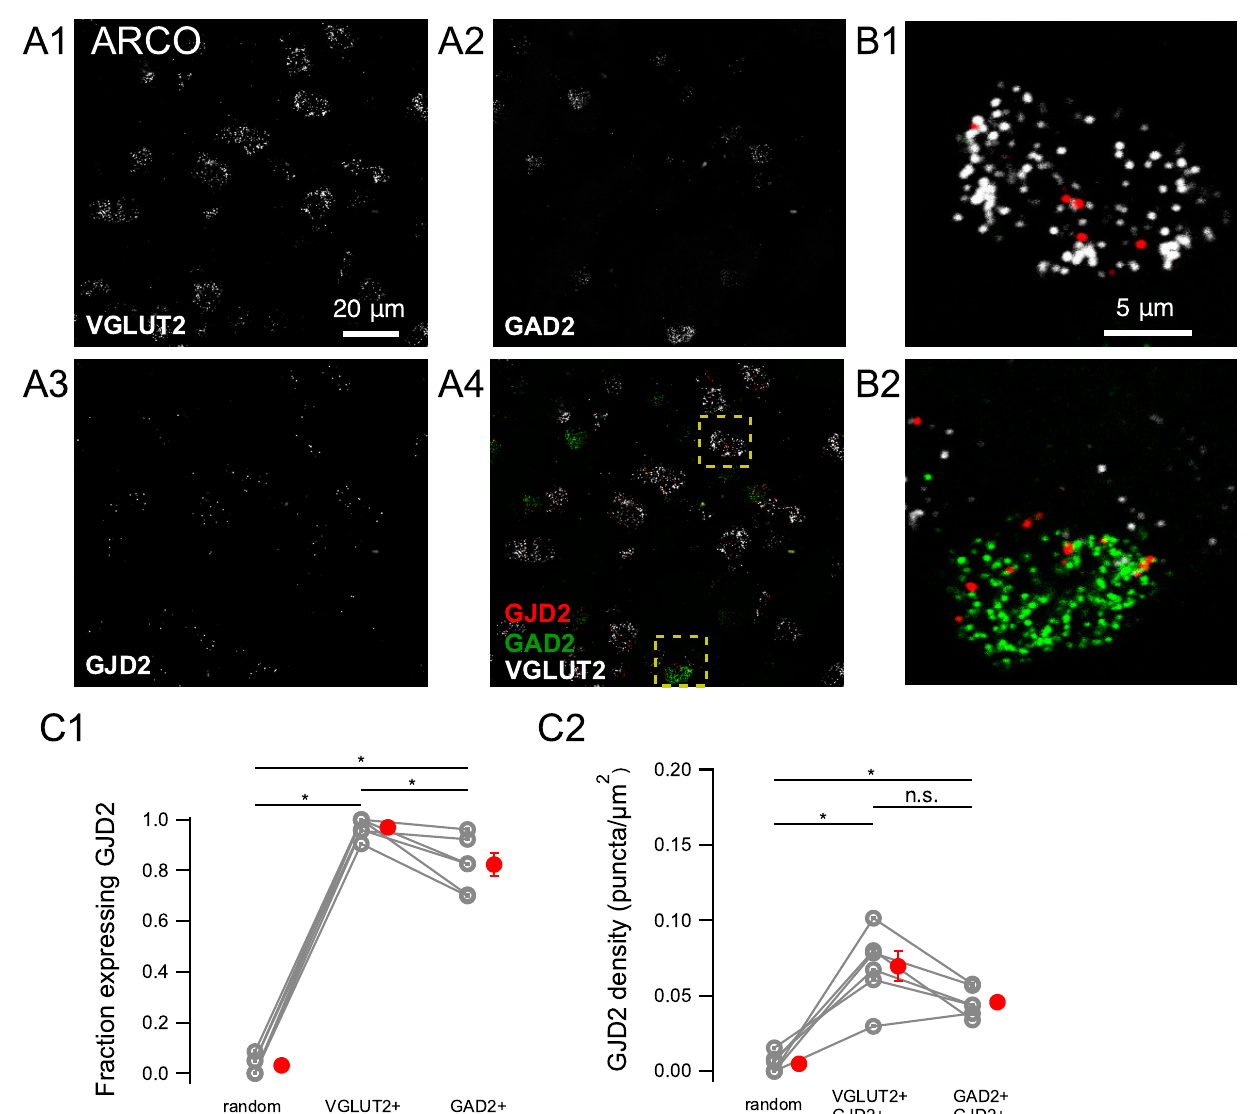
Figure 7. Expression of GJD2 mRNA in the arcopallium from canaries. GJD2 mRNA expression in the arcopallium in both GAD2 mRNA-positive and VGLUT2 mRNA-positive neurons. ( A1 – A4 ) single confocal planes. ( B1 – B2 ) magnification of representative VGLUT2 and GAD2 mRNA-positive cells from the regions highlighted in A4. ( C1 ) fraction of cells expressing GJD2 within each population of labeled neurons: VGLUT2-positive and GAD2-positive cells. ‘Random’, expression in ROIs in the image which did not include DAPI staining and which were neither stained for DAPI nor for VGLUT2/GAD2. ( C2 ) GJD2 mRNA density of GJD2 mRNA-expressing VGLUT2 and GAD2 mRNA-positive neurons. * P < 0.05; n.s., nonsignificant, two-tailed Wilcoxon signed-rank test. Each gray symbol represents the average for one animal. The average values of one animal for the three types of ROI are linked by a line. Red symbols: average across animals. Error bars: ±